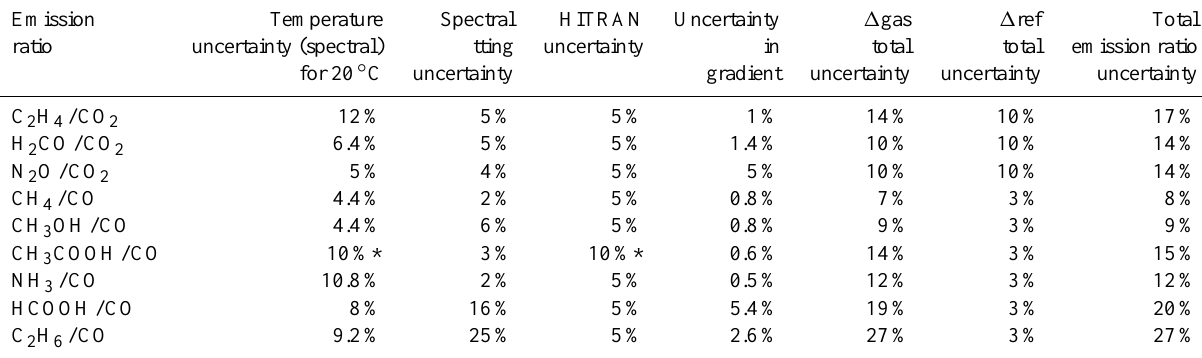
Table B3. Totals and component values of the uncertainty budget for calculating emission ratios. Emission Temperature Spectral HITRAN Uncertainty 1 gas 1 ref Total ratio uncertainty (spectral) fitting uncertainty in total total emission ratio for 20 ◦ C uncertainty gradient uncertainty uncertainty